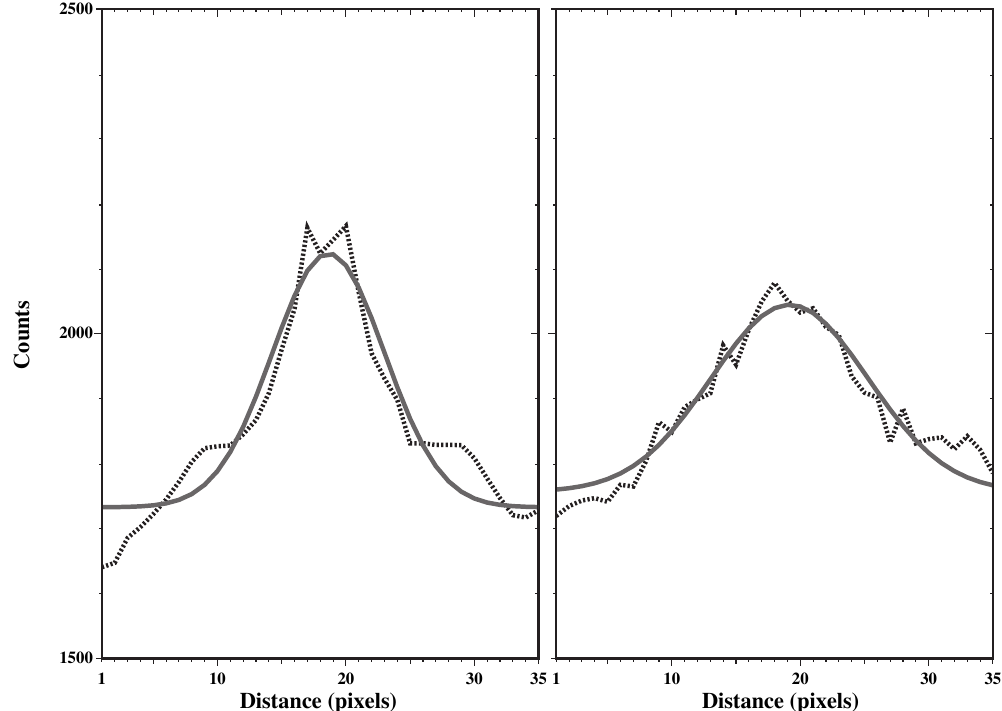
Fig. 6. The relative brightness (dashed lines) plotted along the two red cross-section lines drawn in the lower right image of Fig. 5. The solid gray lines show the Gaussian fit to the brightness profile. The FWHM of these sample structures at the altitude of 135km are 1.0 and 1.4km ( ∼ 10 and 14 pixels,